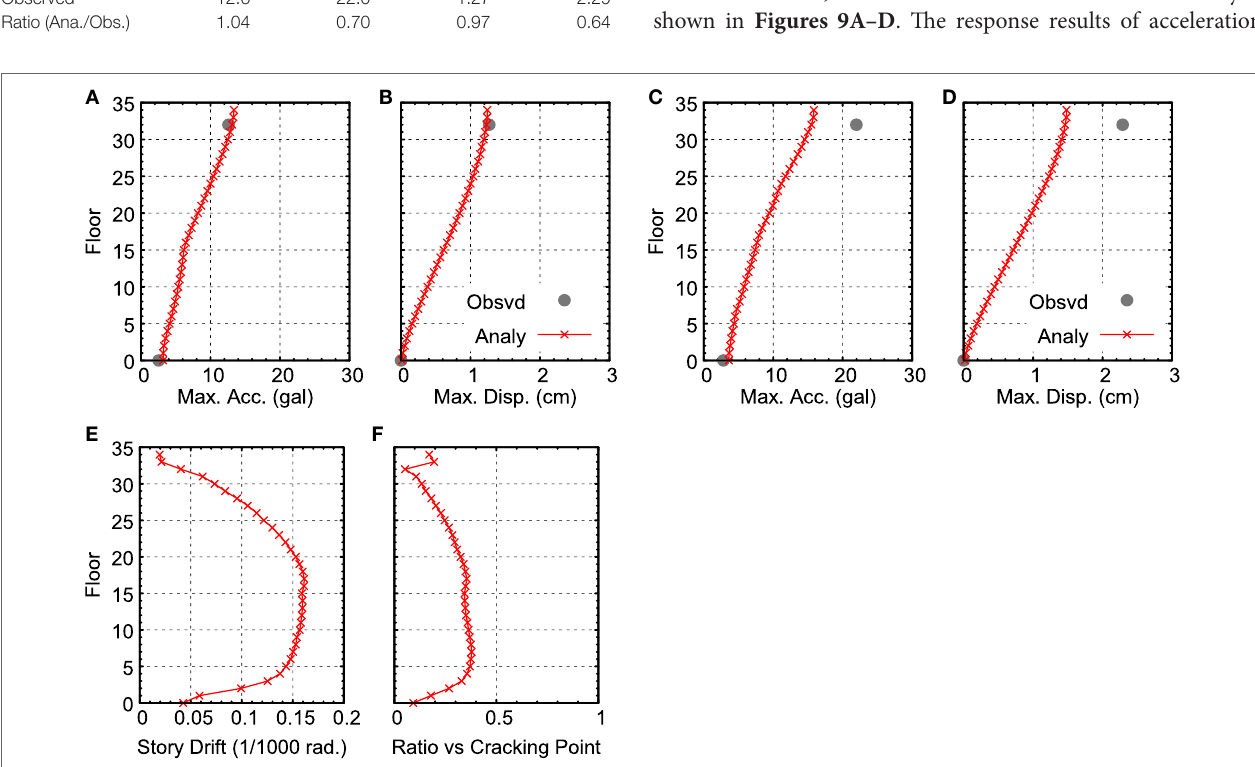
FigUre 7 | Comparison of maximum response for the 3/9 pre-shock: (a) maximum acceleration (N–S direction), (B) maximum displacement (N–S direction), (c) maximum acceleration (E–W direction), (D) maximum displacement (E–W direction), (e) distribution of story drift angle (N–S direction), and (F) distribution of response ratio vs. cracking point (N–S